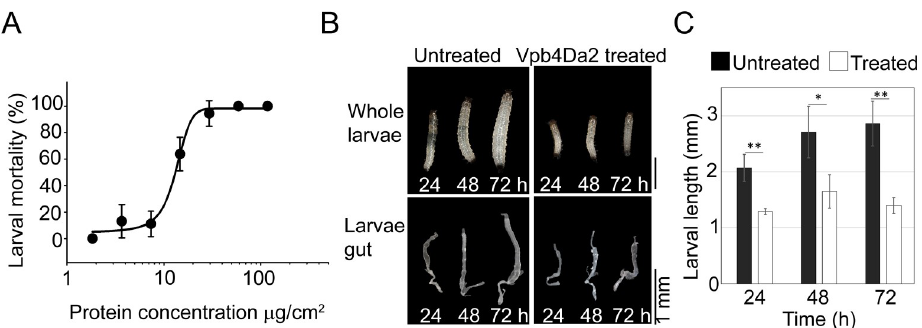
Fig 8. Effects of Vpb4Da2 on WCR larvae development and dissected gut morphology. (A) Vpb4Da2 larvicidal activity on WCR measured by increasing protein concentration. Data points represent mean mortality ( ± SD), not corrected for buffer control mortality (5.56%). (B) Larval growth inhibition and gut morphology evaluation from 24 h to 72 h following exposure to Vpb4Da2. Larval growth was inhibited as early as 24 h. Dissected midguts from treated and untreated larvae are also shown. (C) Bar graph representation of growth inhibition. Data represent mean larval length ( ± SD). Asterisks indicate statistical significance at p = 0.05 ( � ) and p = 0.01( �� ) using the student-t test (n = 5).